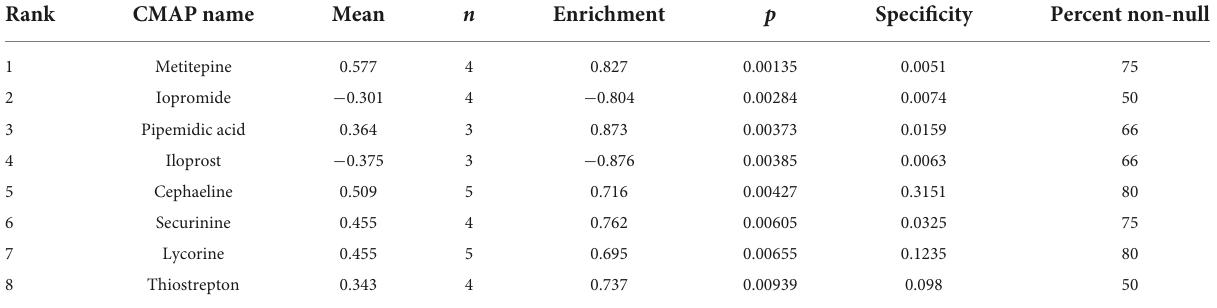
TABLE 4 The result of connectivity map (CMAP) database